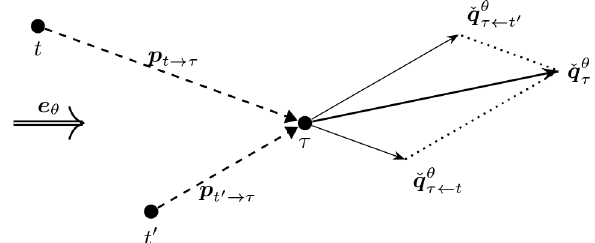
Figure 3. Illustration of how turbine-specific push-cross pseudo- gradient vectors combine into a combined push-cross pseudo- gradient vector and their relation by projection to push-away pseudo-gradient